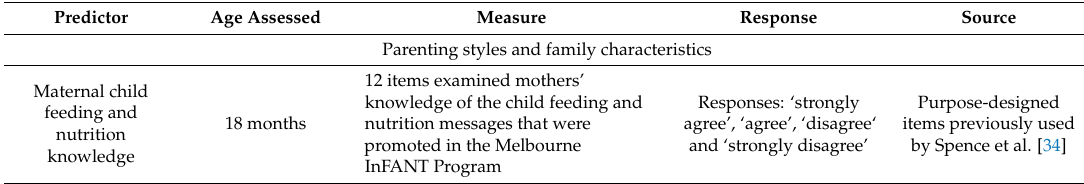
Table 1. List of measures and responses from the Melbourne Infant Feeding, Activity and Nutrition Trial (InFANT) Program questionnaires considered as